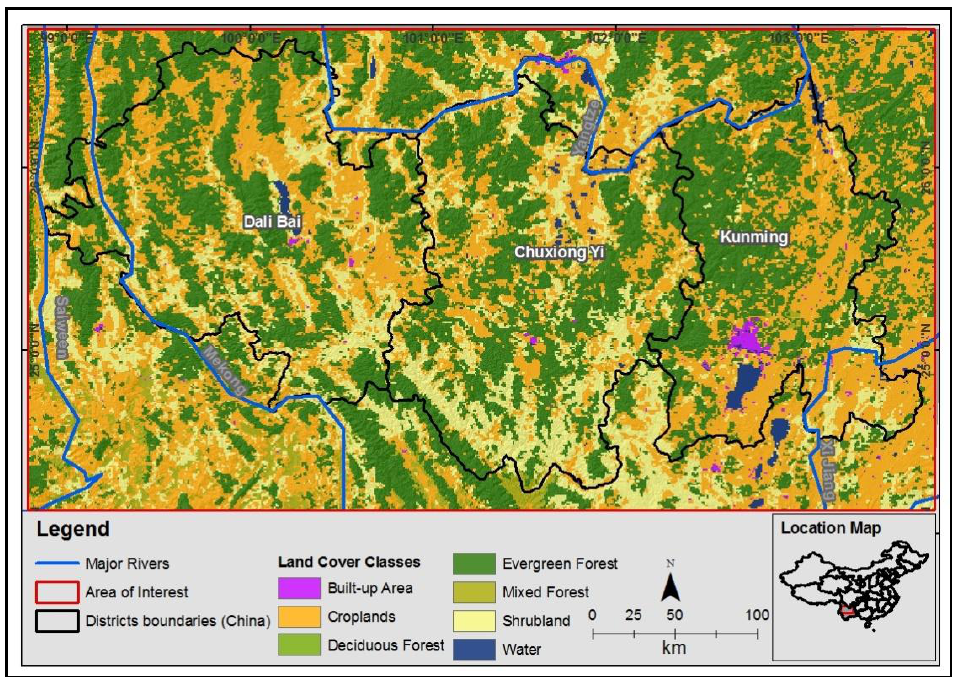
Figure S1. Land cover/land use map of the study area.